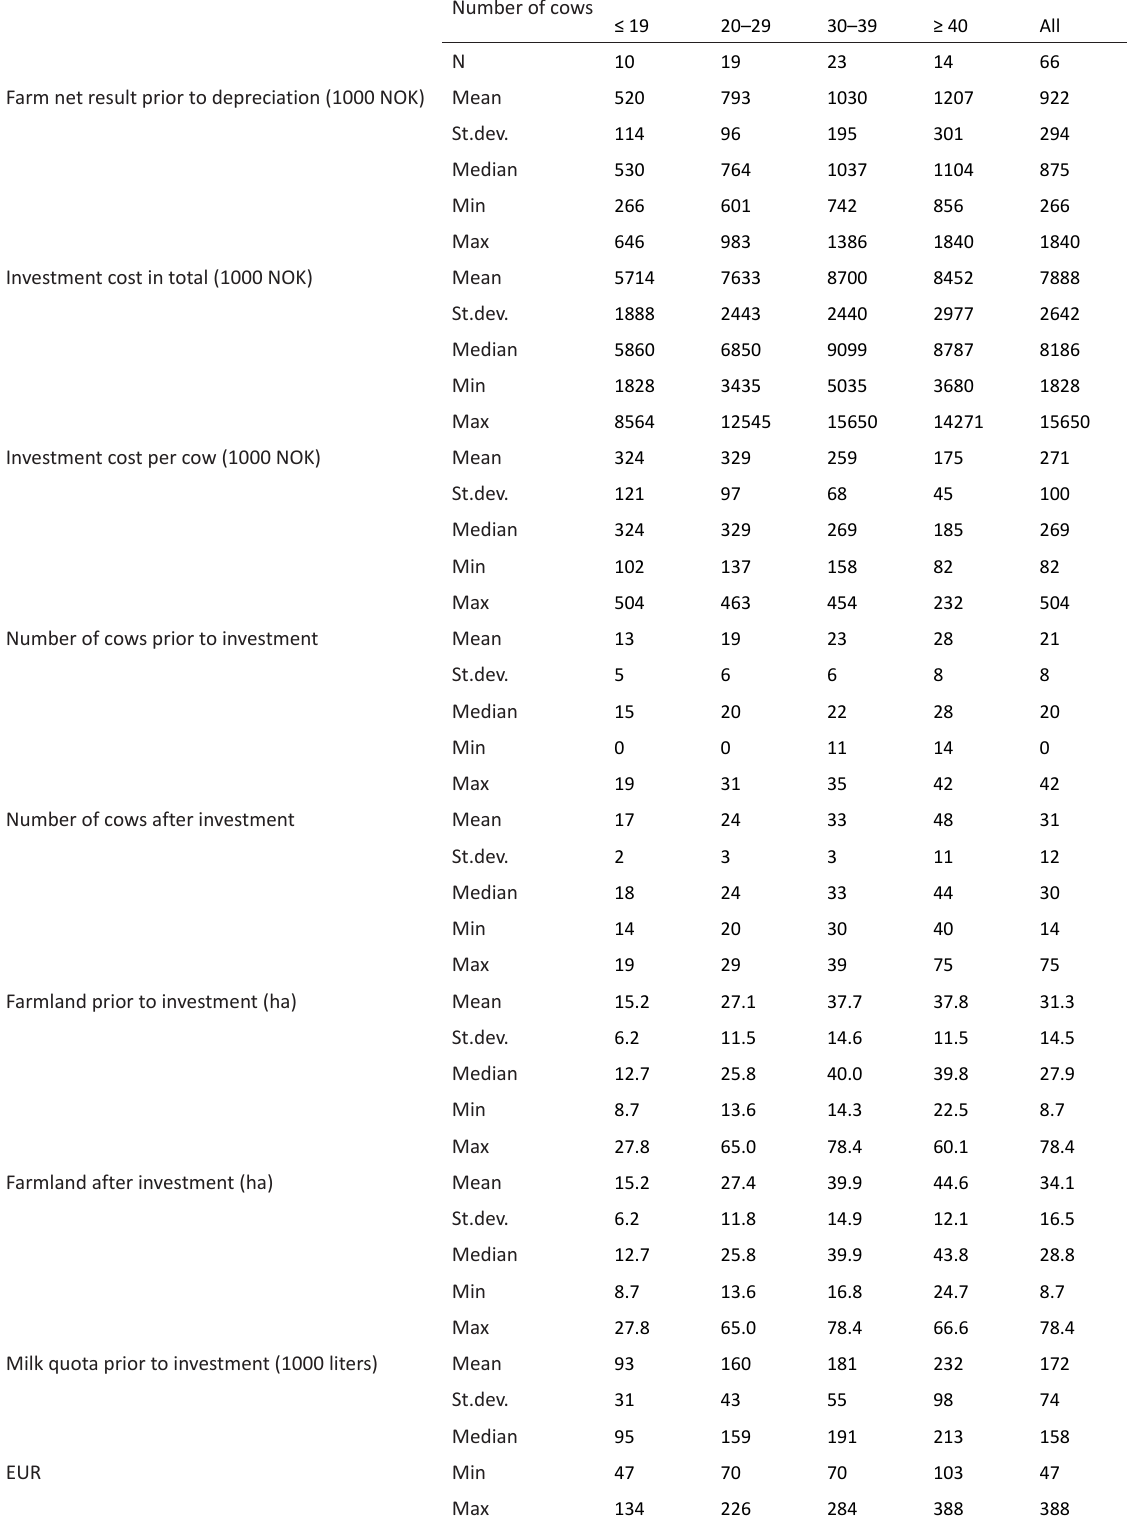
Table 3. Farm net result prior to depreciation after investment, together with investment costs, number of cows, investment cost in total and per cow, farmland, milk quota and milk yield per cow prior to and after investment for the farms in our sample. The farms are grouped according to number of cows after